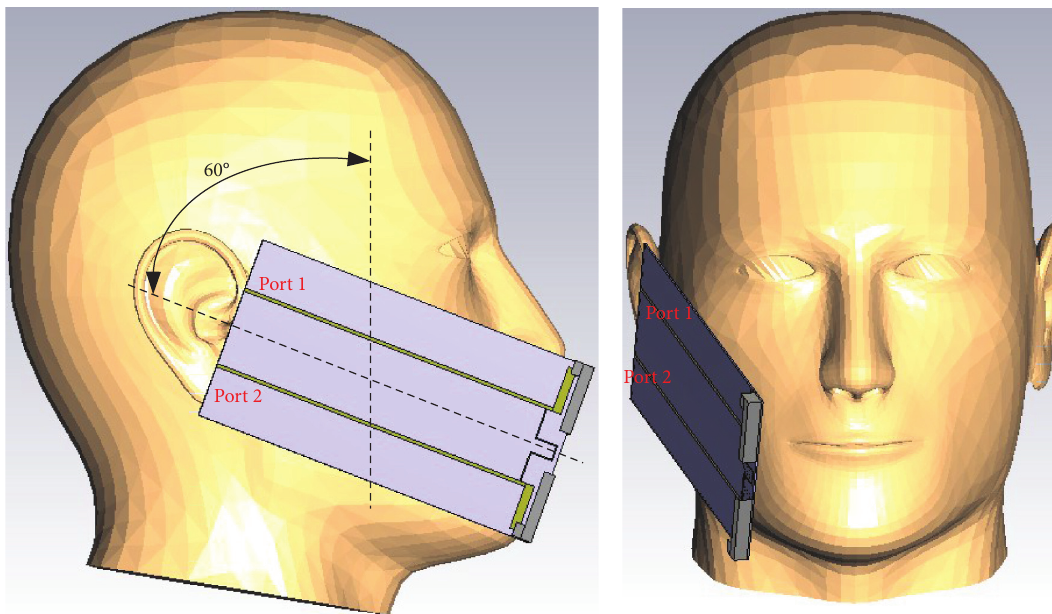
Figure 14: SAR simulation model of the proposed